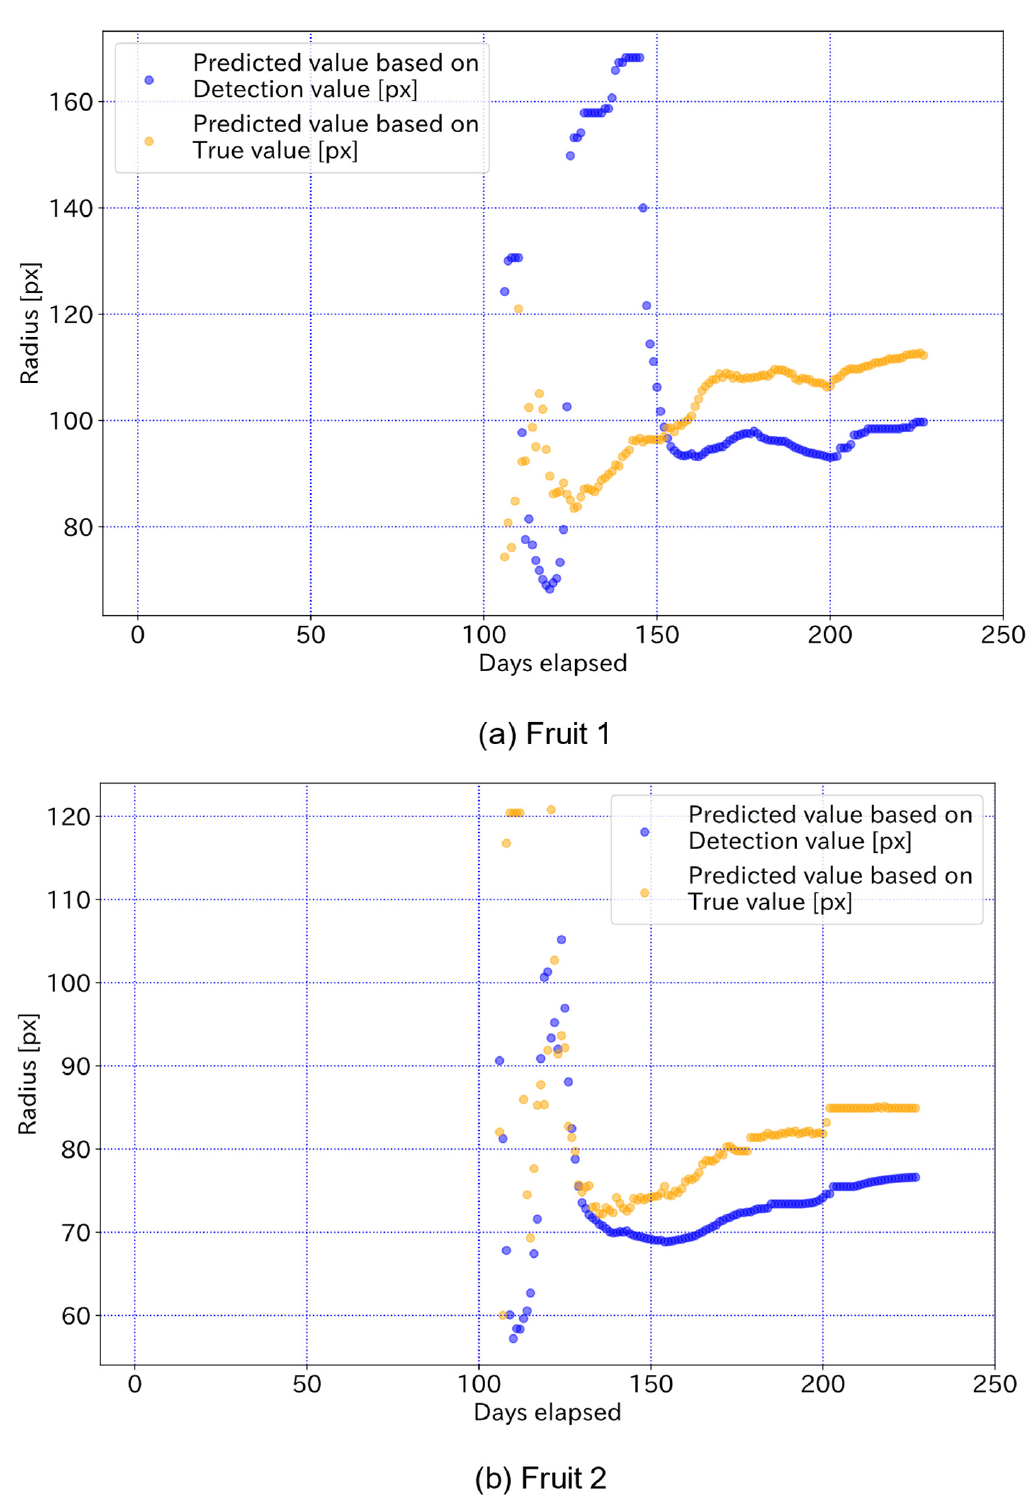
Figure 16. The fruit radius at harvest predicted from the true and detected values. Each prediction can capture the relative growth curve that is close to the true value after approximately 150 elapsed days, even if the target is partially hidden. Before 150 days, the prediction varies widely and has relatively large errors.